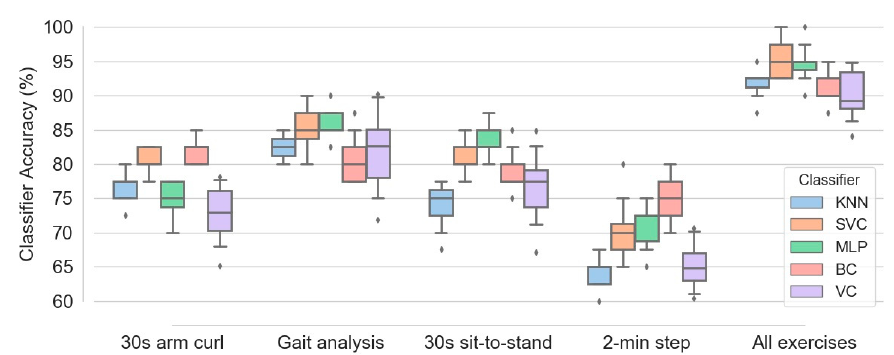
Figure 10. Box plots of various classifiers accuracy obtained based on five configurations of exer- cises, namely 30 s arm curl exercise, gait analysis, 30 s sit-to-stand exercise, 2 min step exercise and combination of all four exercise data.